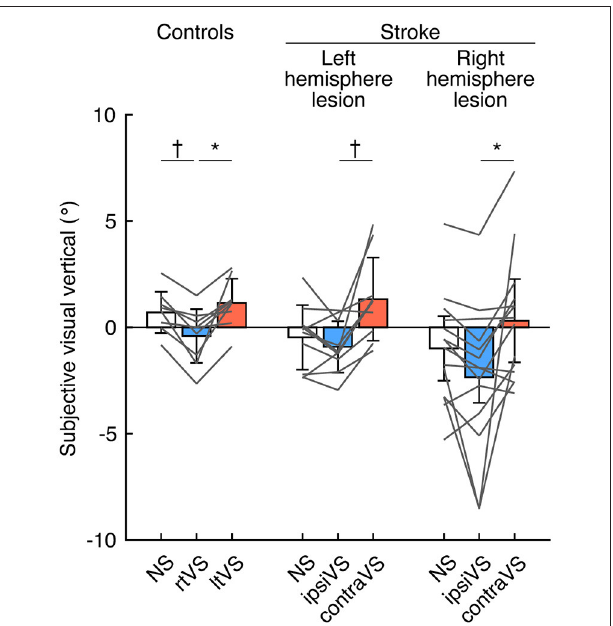
FIGURE 1 | Effects of bipolar galvanic vestibular stimulation on the visual verticality in the controls, patients with a left hemisphere lesion, and patients with a right hemisphere lesion. Each color bar indicates the mean of the subjective visual vertical (SVV) during each type of bipolar galvanic vestibular stimulation (GVS). Positive values indicate rotations to the right side (for the controls) and the ipsilesional side (for the patients with stroke). Each error bar indicates a standard deviation. Each gray line indicates changes in the SVV during each type of bipolar GVS in each participant. NS, no stimulation; rtVS, left-anodal and right-cathodal vestibular stimulation; ltVS, right-anodal and left-cathodal vestibular stimulation; ipsiVS, contralesional-anodal and ipsilesional-cathodal vestibular stimulation; contraVS, ipsilesional-anodal and contralesional-cathodal vestibular stimulation. * p < 0.05; † p < 0.01.